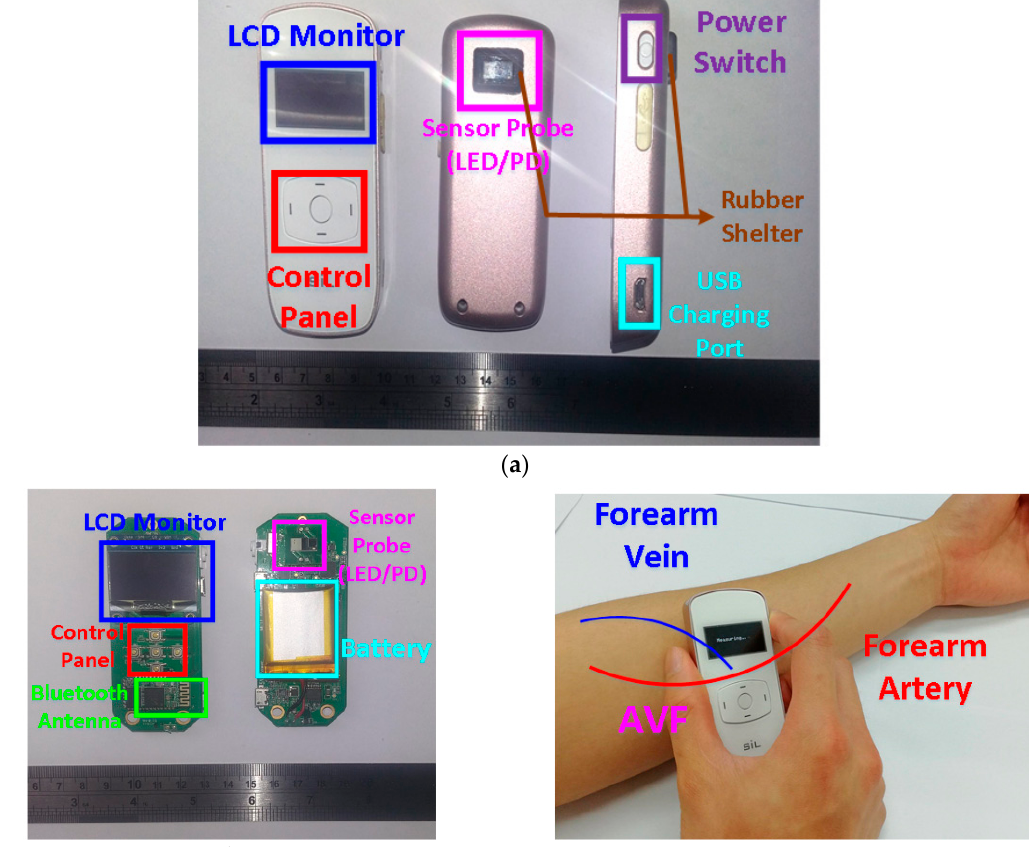
Figure 4. ( a ) The front, back, and side of the designed PPG sensor for assessing AVF. ( b ) The hardware circuitries of the designed PPG sensor. ( c ) The photo of the proposed PPG sensor measuring.